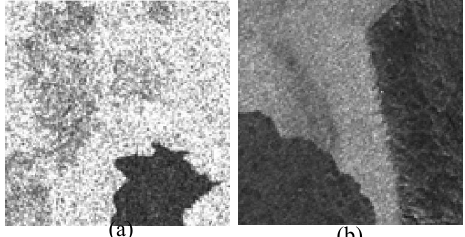
Figure 3. Real SAR images: (a) coastal image, and (b) estuary image.